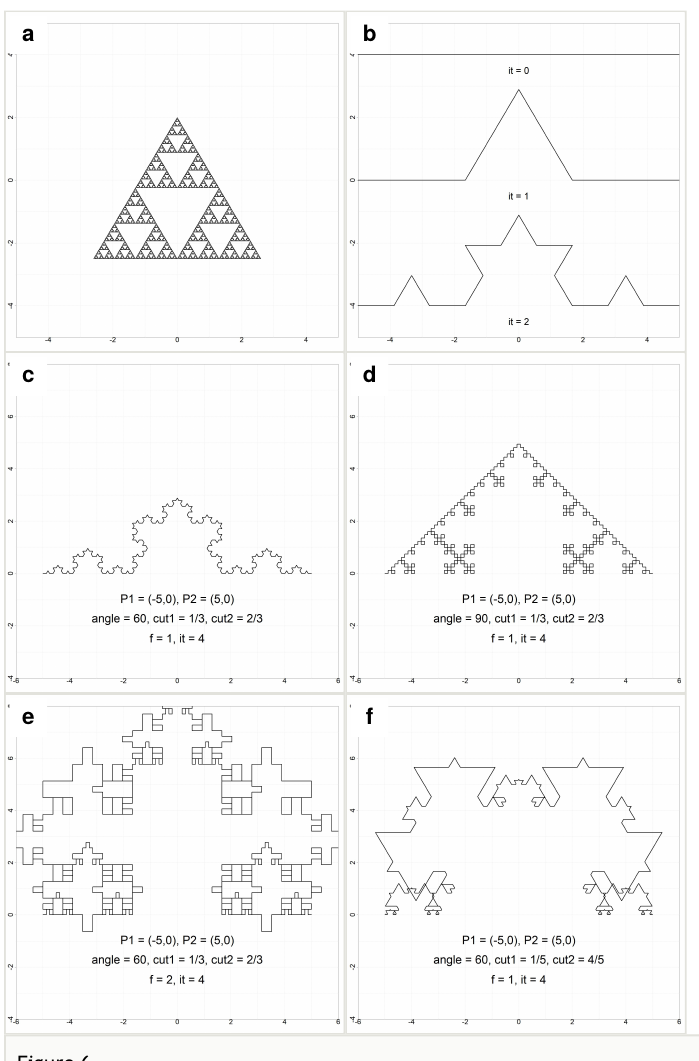
Examples of di ff erent fractals produced with the functions of the LearnGeom package. The examples obtained with FractalSegment show how minimal modi fi cations of the parameters can lead to very di ff erent